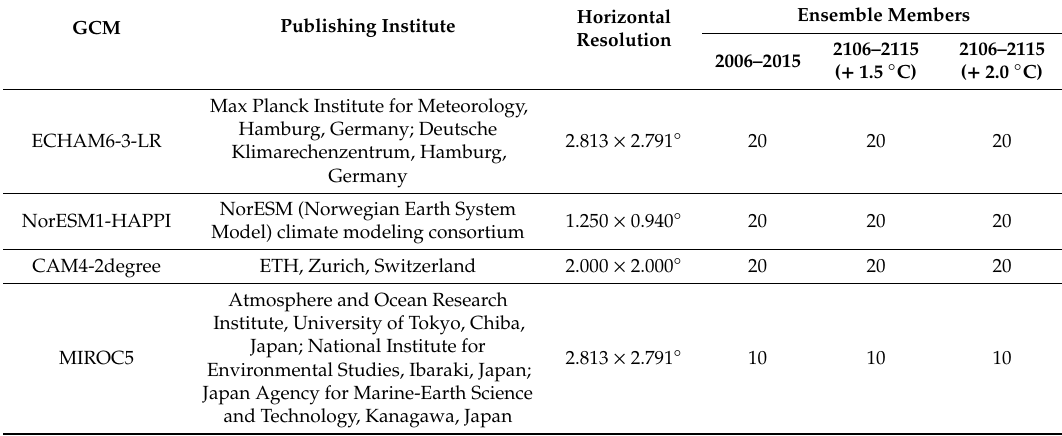
Table 1. The detailed information of the Global Climate Models (GCMs) used in the Half a Degree Additional Warming Projections, Prognosis and Impacts